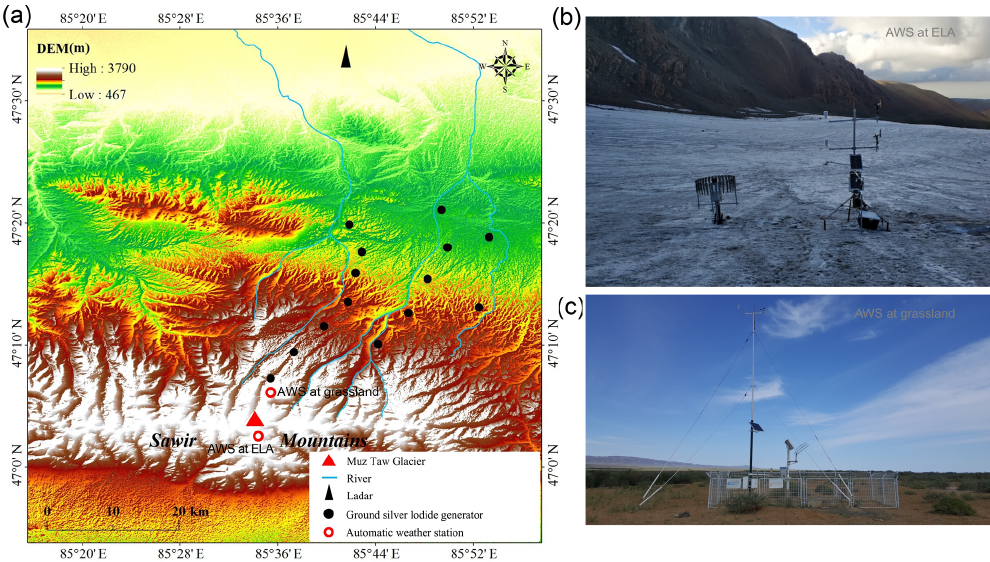
Figure 2. (a) The map of the study area including the Muz Taw Glacier, the two automatic weather stations (AWSs) set up at the equilibrium line elevation (ELA), and the forefield of the glacier and the distribution of the silver iodide smog generators along the Ulequin Urastu River and Ulast River in the Sawir Mountains for seeding artificial precipitation. (b) The AWS set-up at ELA and (c) the AWS set-up at grassland, with a straight distance of ∼ 5km north to the AWS at ELA.